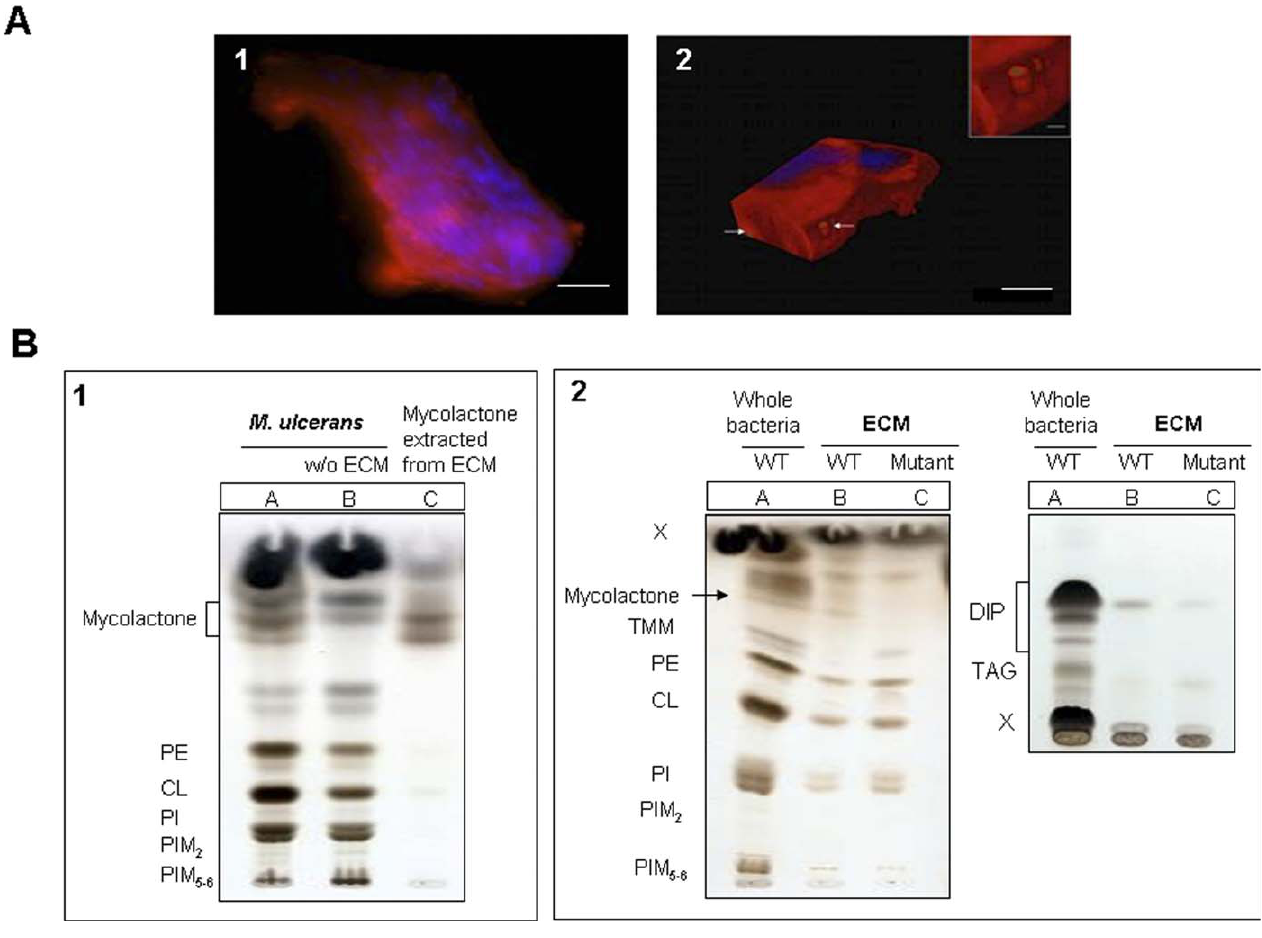
Figure 5. Analysis of Carbohydrate and Lipids in